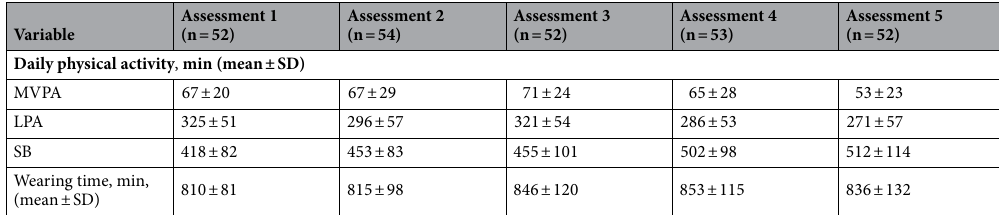
Table 2. Accelerometer data from participants who met the device-wearing criterion a in this five-year longitudinal study of physical activity in children transitioning from primary to secondary school. Assessments 1, 2, 3, 4, and 5 took place in grades 4, 5, 6, 7, and 8, respectively. MVPA moderate-to-vigorous intensity physical activity, LPA light-intensity physical activity, SB sedentary behavior, SD standard deviation. a The device-wearing criterion required that the accelerometer be worn for at least 600 min/day during each assessment.